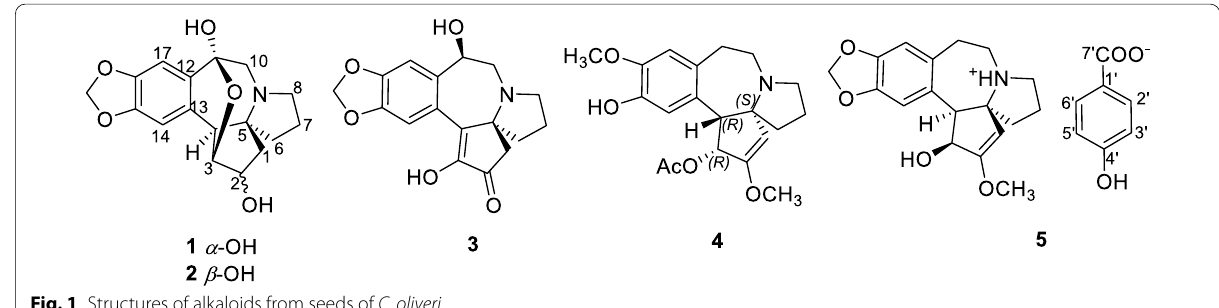
Fig. 1 Structures of alkaloids from seeds of C.